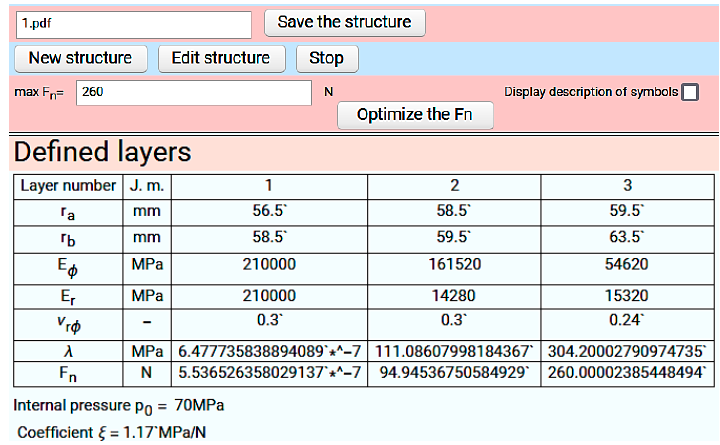
Figure 27. Calculation results of fibre tension force.